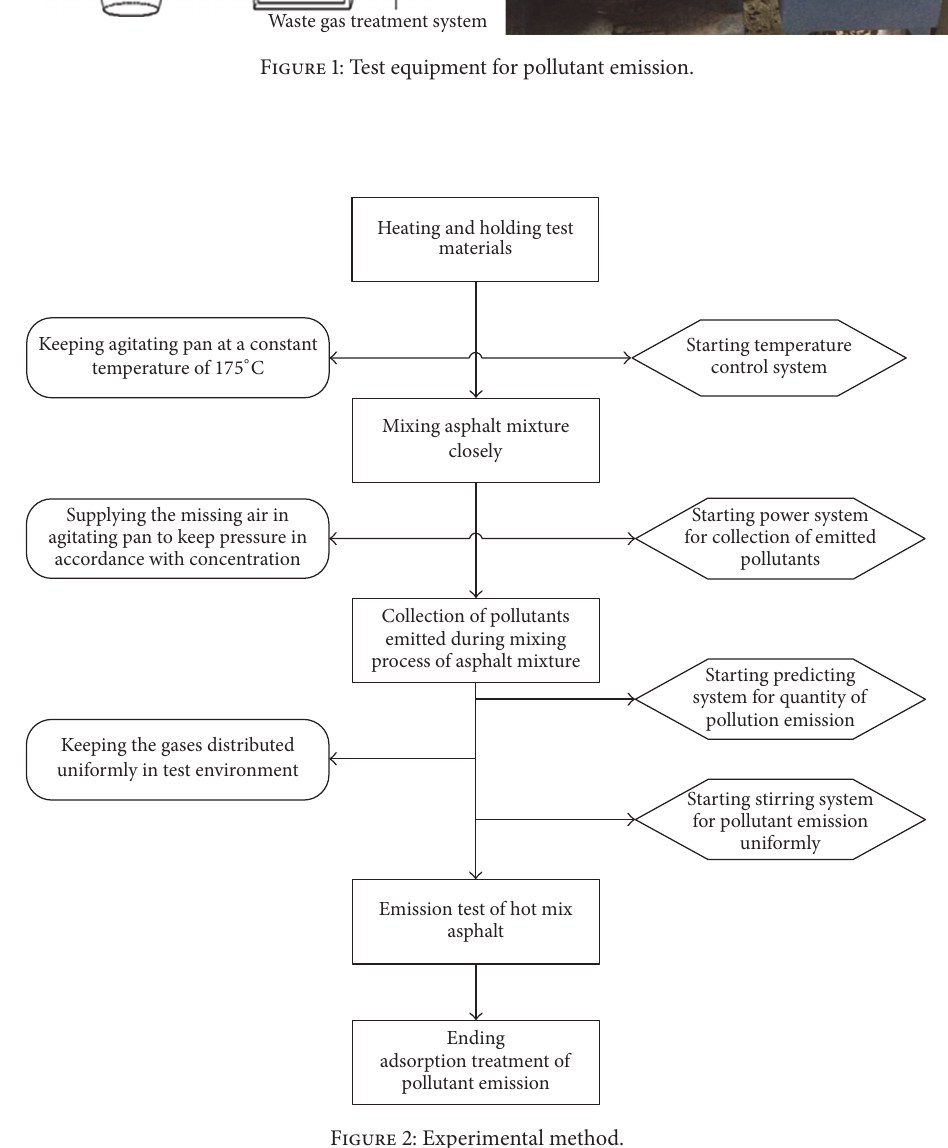
Figure 2: Experimental